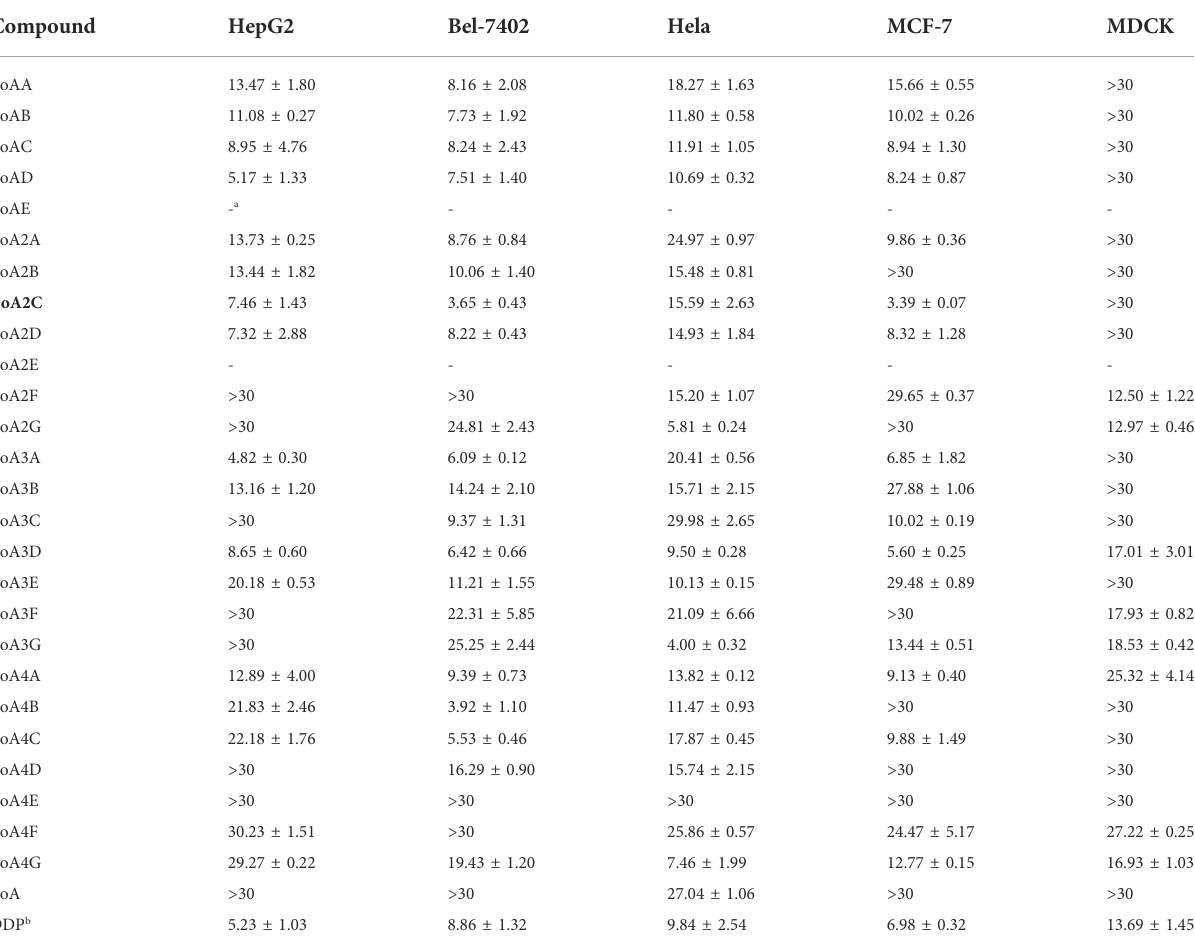
TABLE 2 Inhibition effects of BoA derivatives on the growth of tumor cells and MDCK cells in vitro